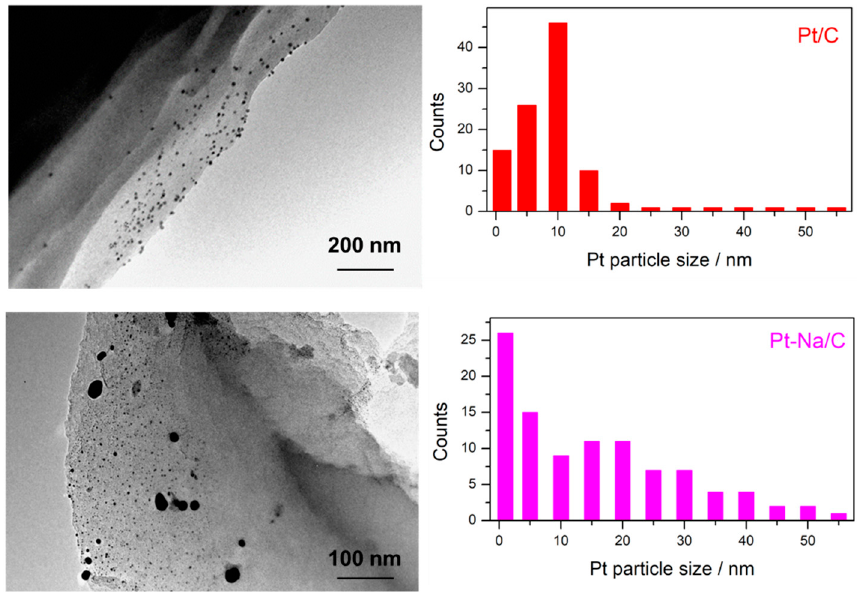
Figure 2. TEM micrographs and metal particle size distribution of Pt/C and Pt–Na/C samples. All samples present type I isotherms characteristic of microporous materials (data not shown).